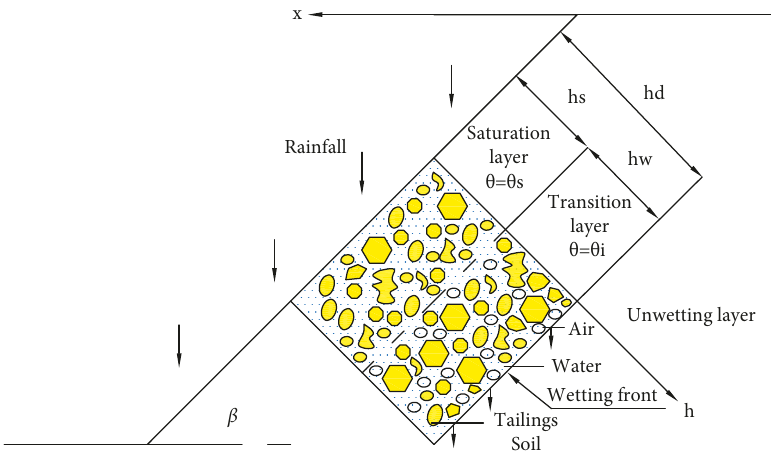
Figure 2: The schematic diagram of improved GA infiltration